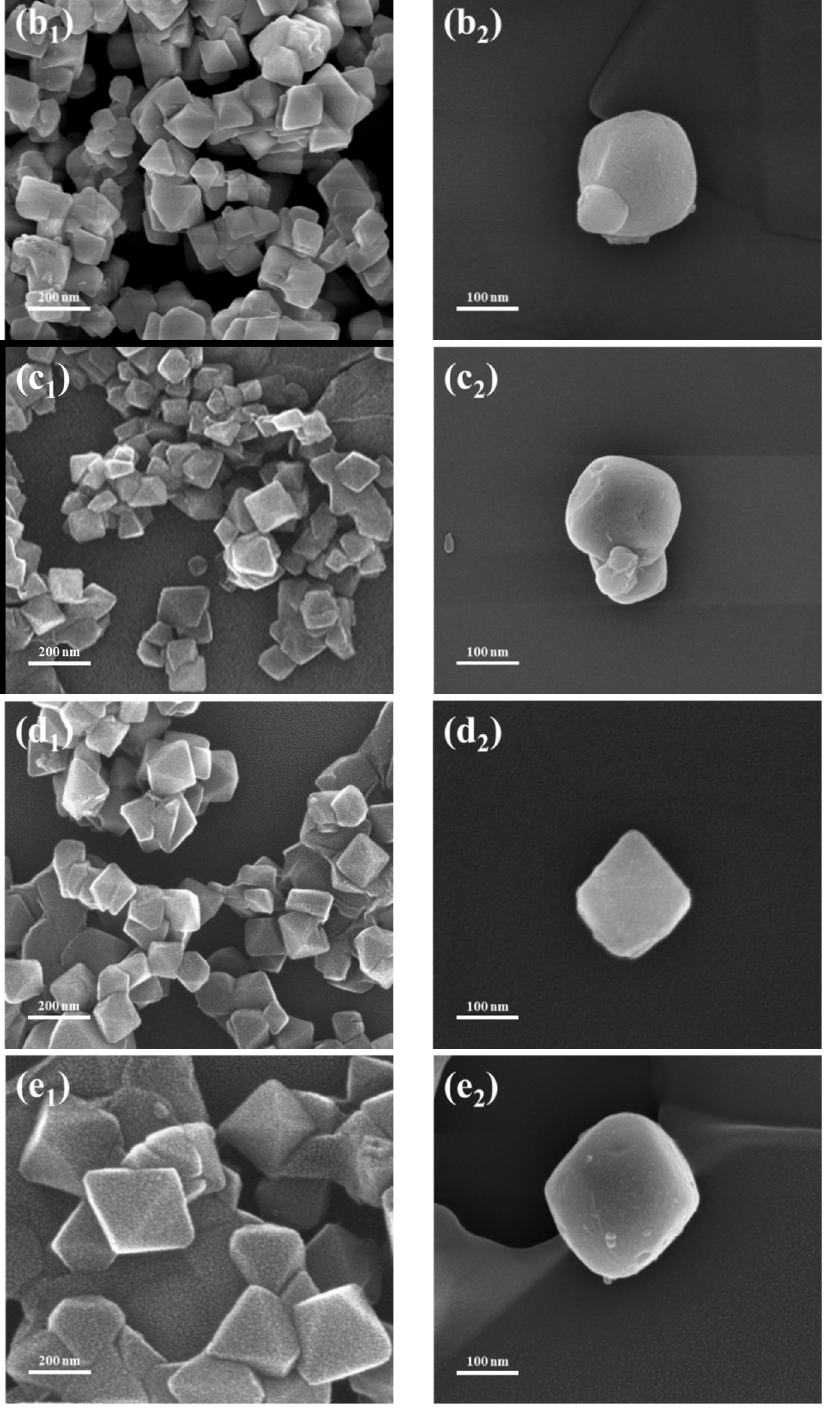
Figure 4. SEM of ( a 1 ) UiO-66 and ( b 1 ) UiO-66 25% and ( c 1 ) UiO-66 50% and ( d 1 ) UiO-66 75% and ( e 1 ) UiO-66-NH 2 at lower magnification; SEM of ( a 2 ) UiO-66 and ( b 2 ) UiO-66 25% and ( c 2 ) UiO-66 50% and ( d 2 ) UiO-66 75% and ( e 2 ) UiO-66-NH 2 at higher magnification.